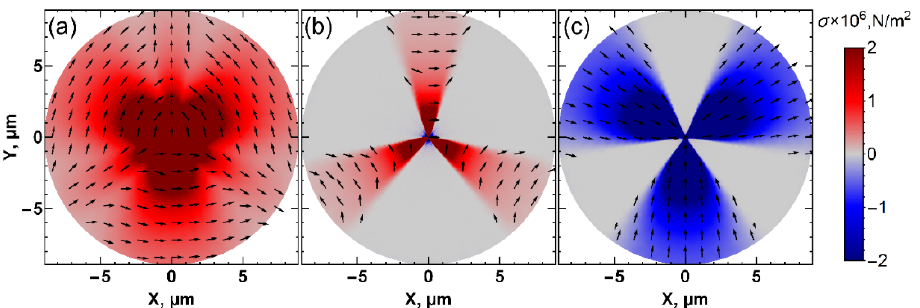
Figure 6. The distributions of ( a ) σ 1 , ( b ) σ 2 , and ( c ) σ 3 principal components of the stress tensor at the 20 nm depth. The black arrows indicate strain direction.